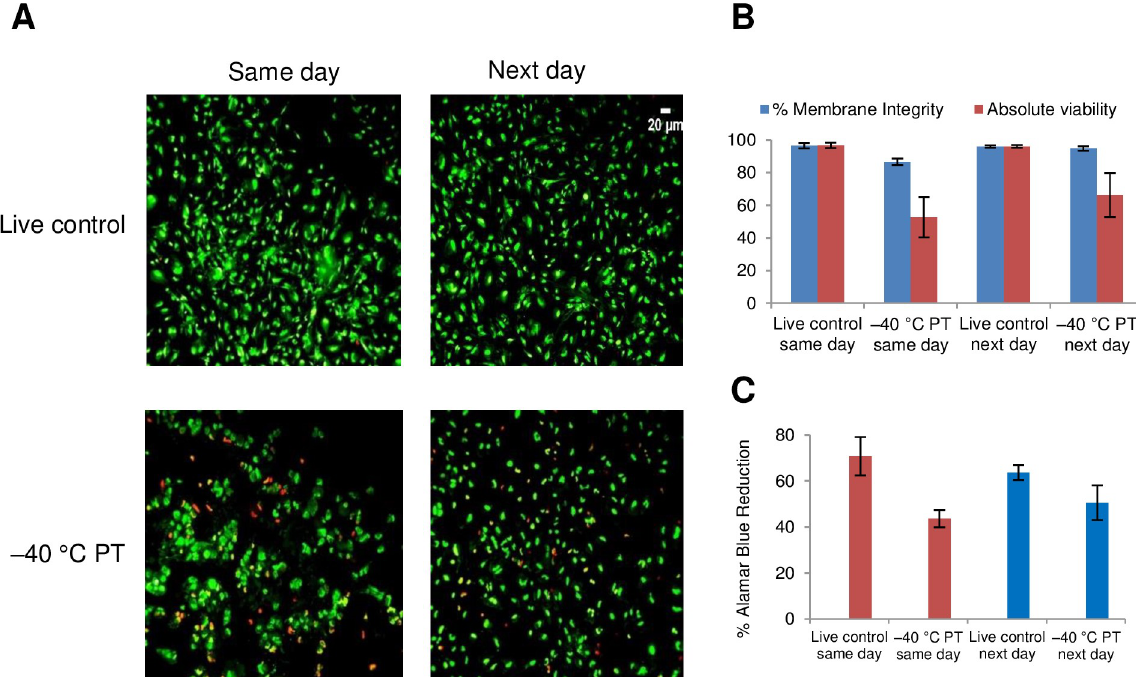
Fig 8. Cryopreservation of astrocyte monolayers. (A) Fluorescent microscope images of astrocyte monolayers on fibronectin-coated Rinzl coverslips. Live control samples were unfrozen, and the frozen samples (labelled –40˚C PT) were cooled at 1˚C/min to –40˚C in the presence of 5% DMSO, 6% HES, and 2% chondroitin sulfate, plunged and stored in liquid nitrogen, and rapidly thawed. Cryoprotectant was removed with a single PBS wash, and the monolayers assessed either on the same day of thaw or after post-thaw overnight incubation (next day). The monolayers were stained with SYTO 13 and GelRed; scale bar for live control, next day, applies to all images. (B) Percent membrane integrity (blue bars) and absolute viability (red bars) in each captured image were quantified using Viability3 automated cell counting software. Data represent the mean ± SEM of three independent experiments using three to five coverslips per condition. (C) Metabolic activity of astrocyte monolayers by AlamarBlue reduction. Data represent the mean ± SEM of three independent experiments using four coverslips per condition.